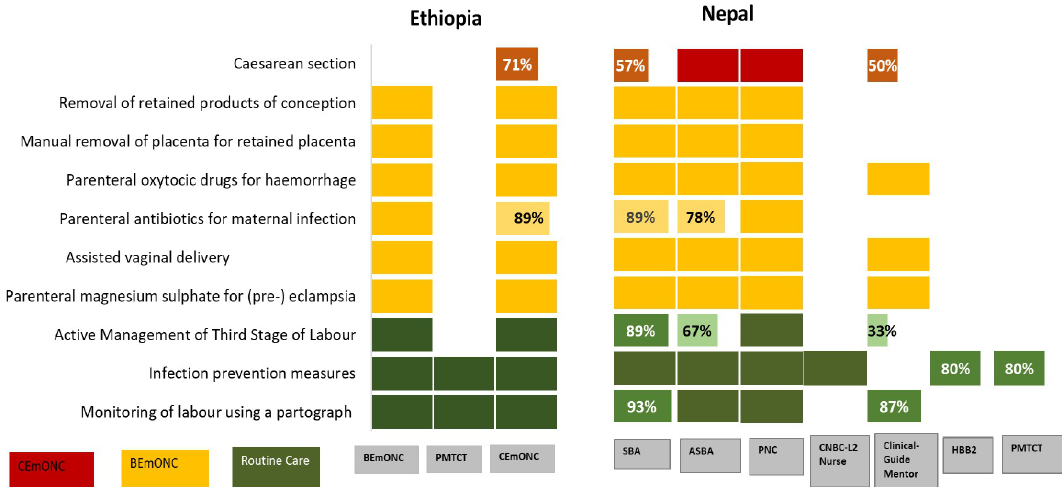
Fig 3. Maternal care interventions in routine, basic and comprehensive emergency care in Ethiopia and Nepal. We removed ECEB, IMNCI NICU, NBC-2012 manuals (Ethiopia) and CNBC- Level 2 for doctors, FB-IMNCI for doctors (Nepal) from the graph since they did not have any maternal health